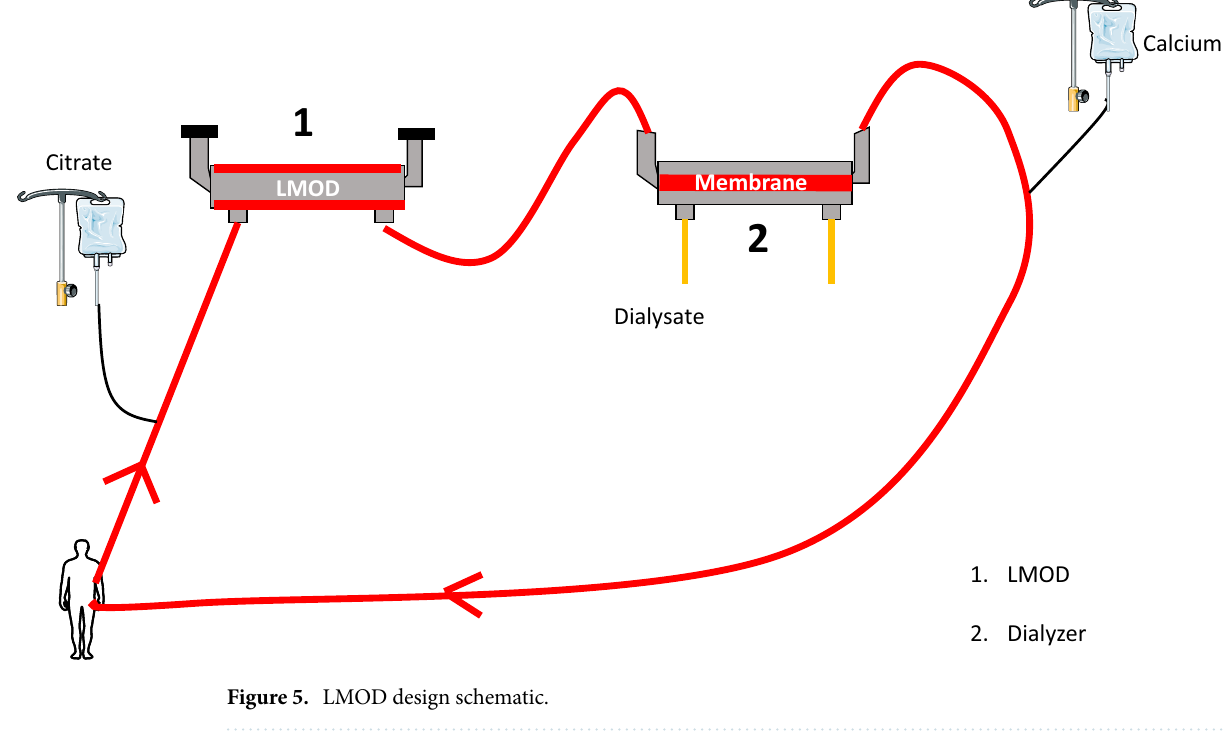
Figure 5. LMOD design